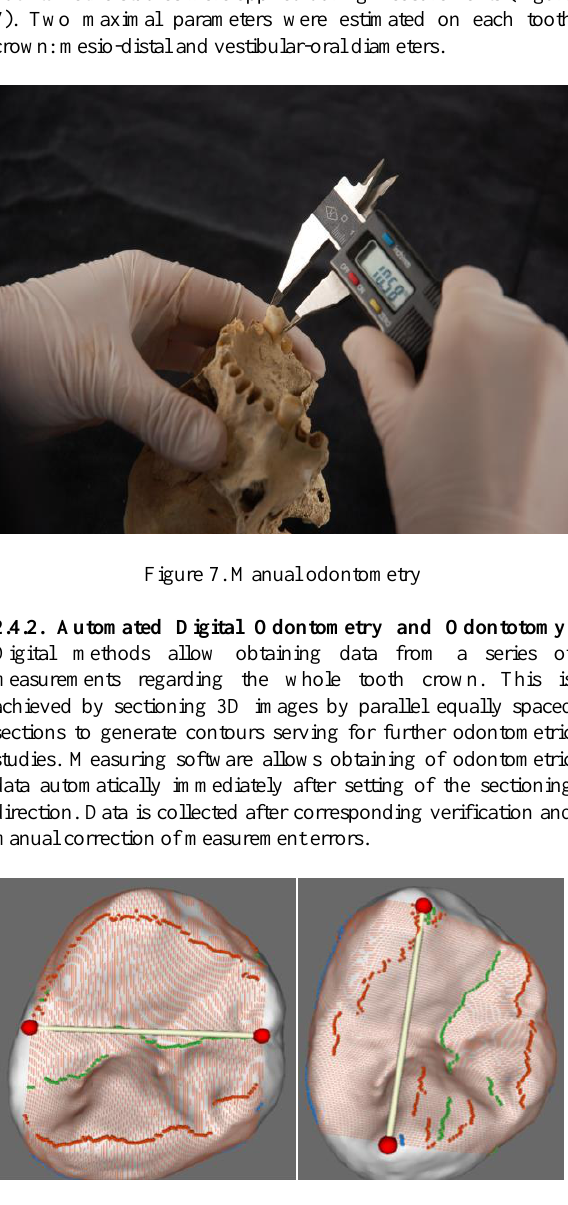
Figure 8. Two directions of odontotomy